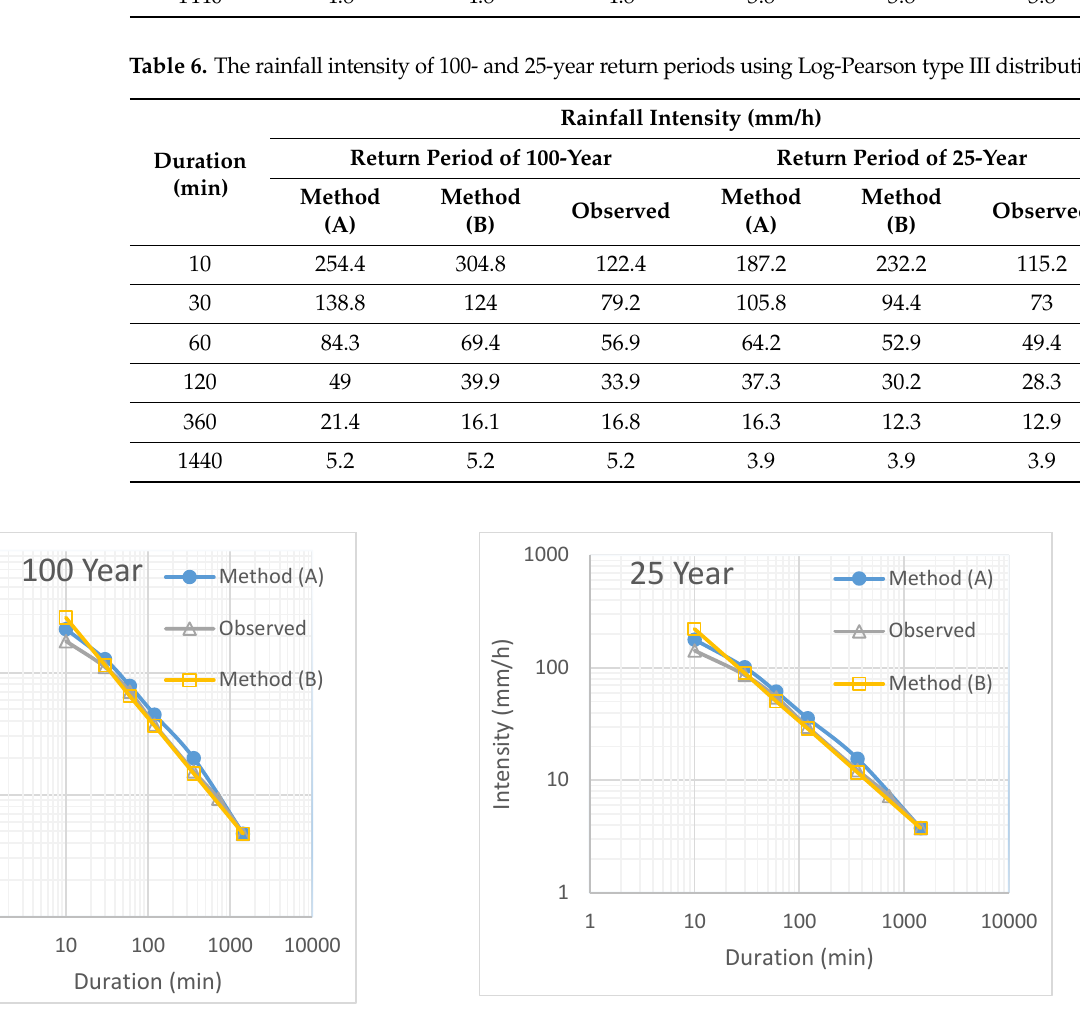
Table 5. The rainfall intensity of 100- and 25-year return periods using Gumbel distribution.